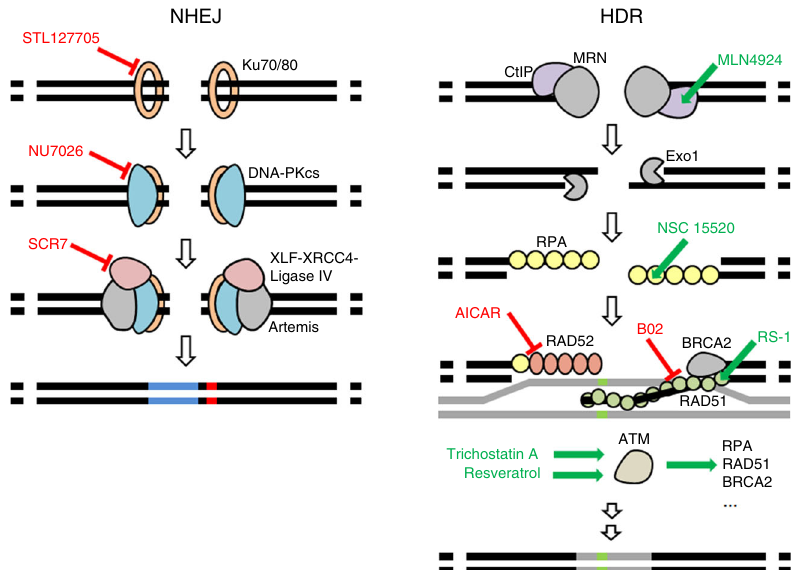
Fig. 1 Small molecules described or anticipated to target key proteins of NHEJ and HDR. Proteins are labeled with black text and inhibitors and enhancing small molecules are marked red and green, respectively. STL127705, NU7026, or SCR7 have been described to inhibit Ku70/80, DNA-PK, or DNA ligase IV, respectively. MLN4924, RS-1, Trichostatin A, or Resveratrol have been described to enhance CtIP, RAD51, or ATM, respectively. NSC 15520 has been described to block the association of RPA to p53 and RAD9. AICAR is an inhibitor of RAD52 and B02 is an ihibitor of RAD51. For simplicity, some proteins and protein interactions are not